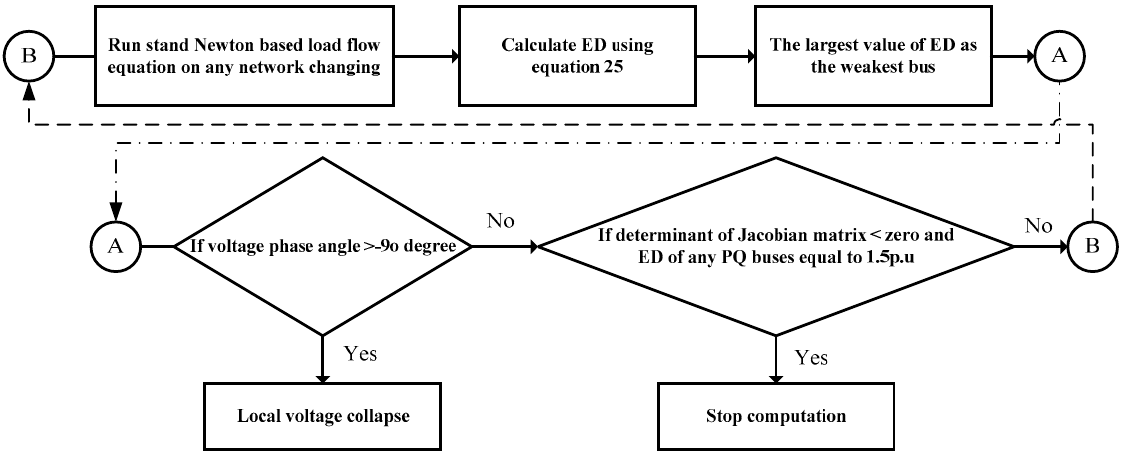
Figure 11. Online voltage stability procedure using ED.